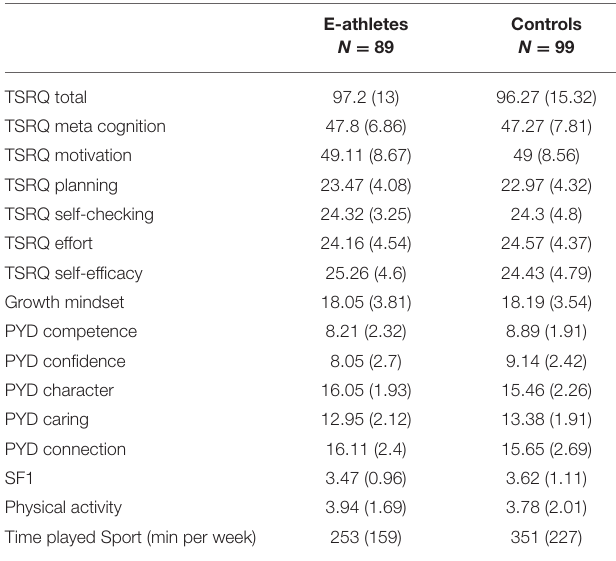
TABLE 1 | Means and standard deviation for the dependent variables at baseline for the e-athletes and control